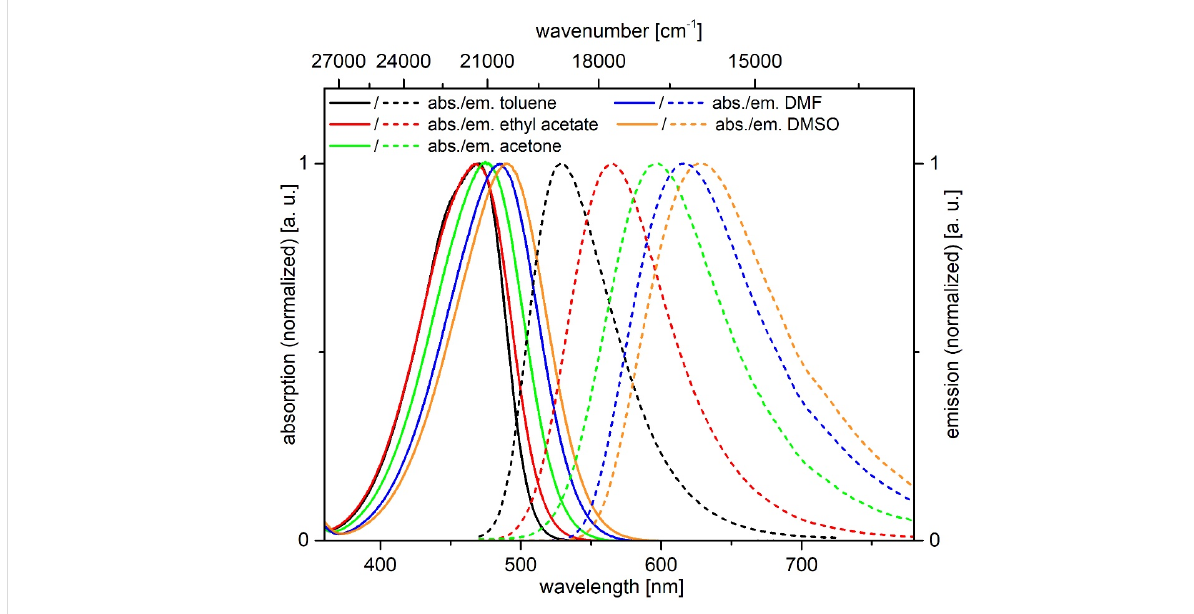
Figure 12: Absorption (solid lines) and emission (dashed lines) spectra of α -pyrone 6c in five solvents of different polarity (recorded at T = 298 K).